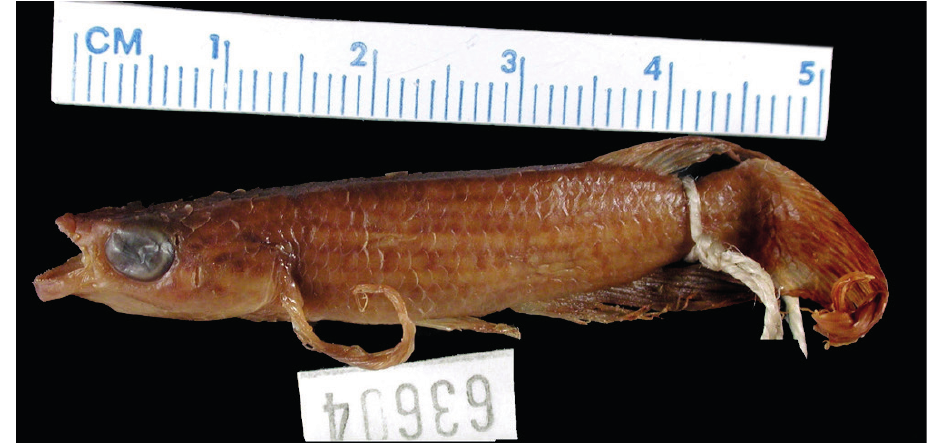
FIGURE 7 | Moema pepotei , CAS-SU 63604, holotype, male, 45.4 mm SL, Brazil, Rondônia, Forte Príncipe da Beira (on Bolivian border). Source: CAS Ichthyology Primary Types